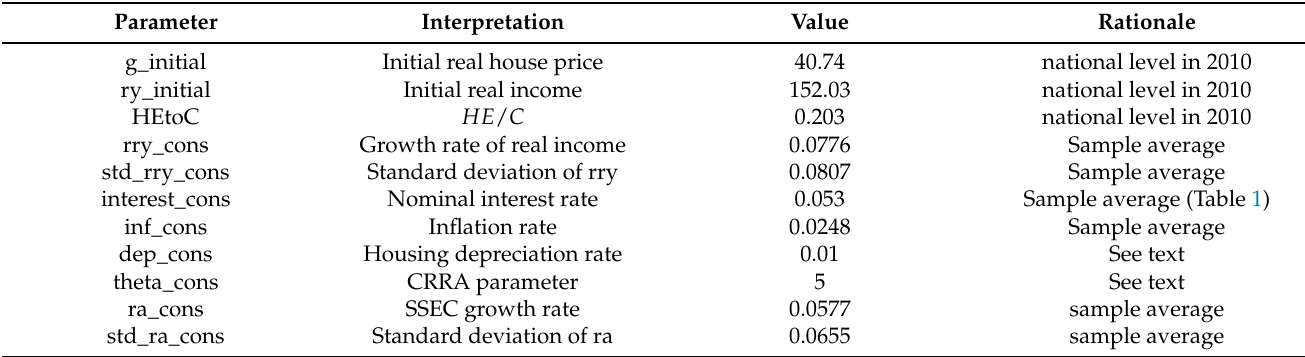
Table A1. Values Used in the